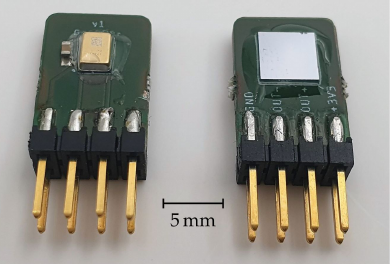
Figure 3. Detector module PCB with photoacoustic transducer ( right , front side) and the MEMS microphone ( left , back